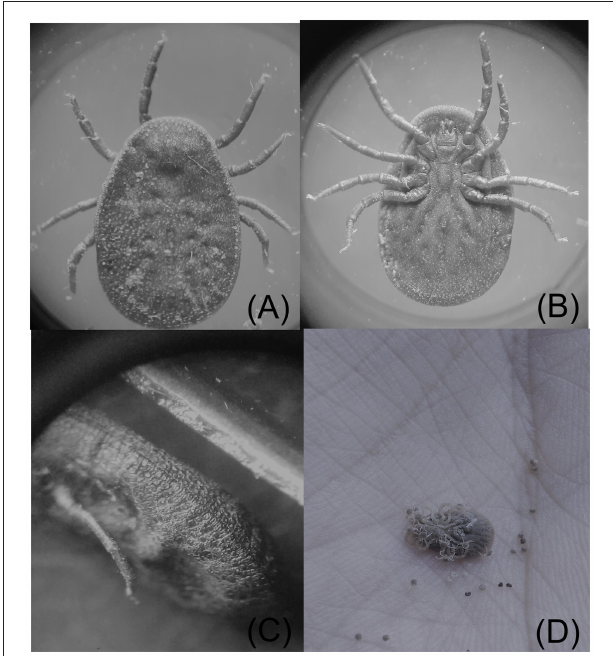
FIGURE 2 | (A) Dorsal, (B) ventral, and (C) lateral view of female A. persicus . (D) Maternal-like behavior in A. persicus .